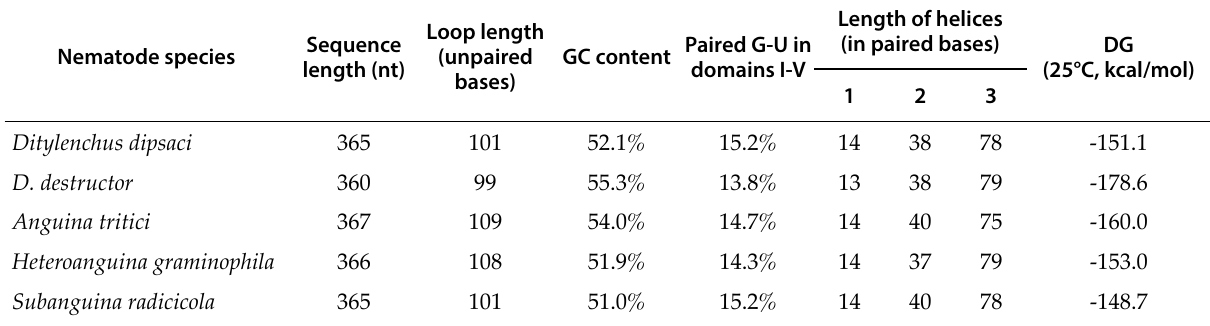
Table 2. Statistics of the secondary structures (D2-LSU rRNA) proposed in this study.